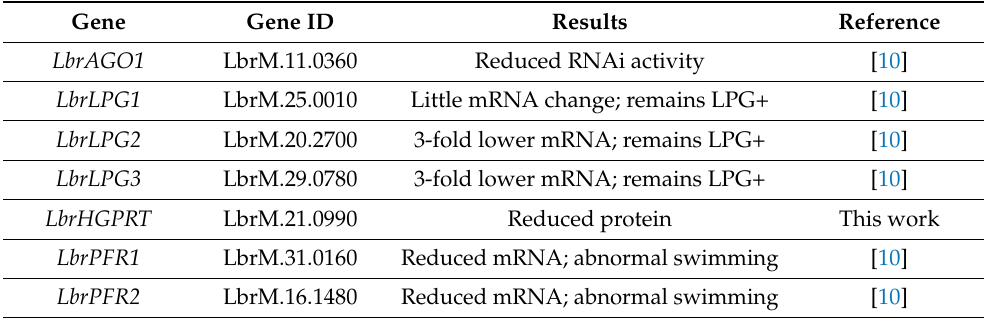
Table 2. Summary of genes targeted by RNAi in L. (Viannia) sp. and their